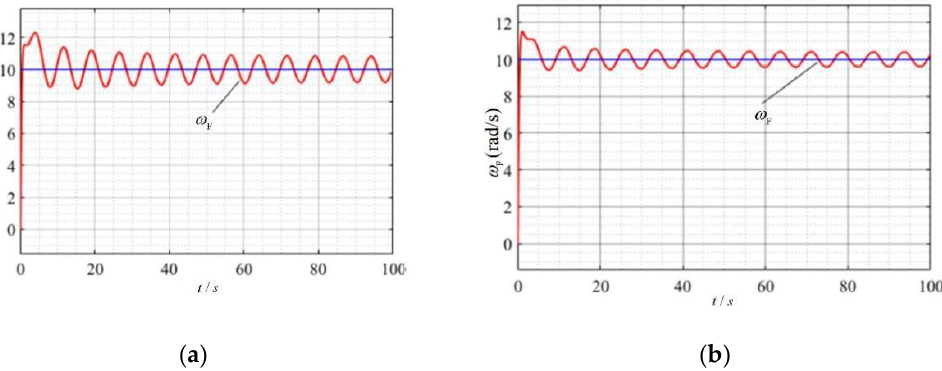
Figure 20. Output speed curve of the generator for varying 𝐹 f (𝑠) parameters: ( a ) scheme (a); ( b )